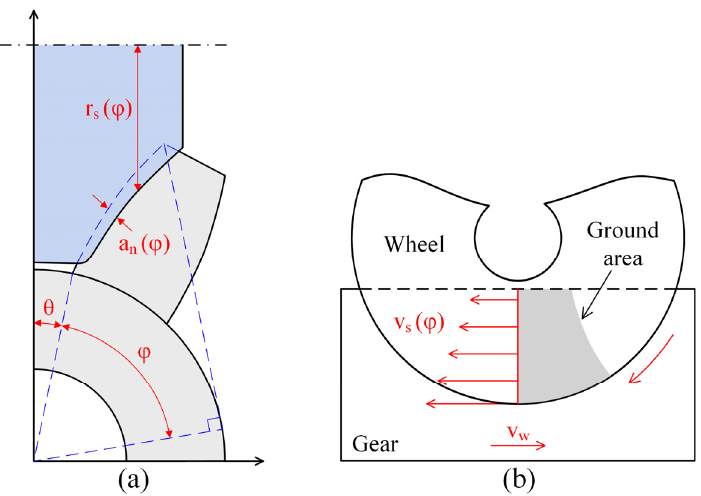
Figure 10. ( a ) Local wheel radius and cutting depth, and ( b ) local cutting depth and contact